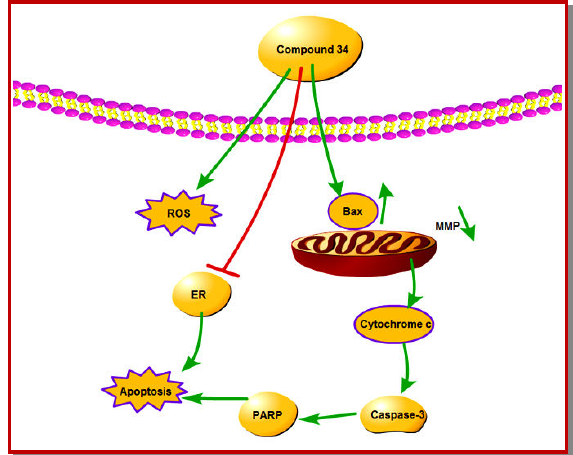
Figure 8: The possible signaling pathway for compound 34- induced apoptosis in MCF-7 cells Compound 34 can produce ROS and reduce mitochondrial mem- brane potential, release cytochrome c from mitochondrial, activate caspase-3, and finally lead cells to death. In addition, compound 34 can also trigger apoptosis by interacting with ER